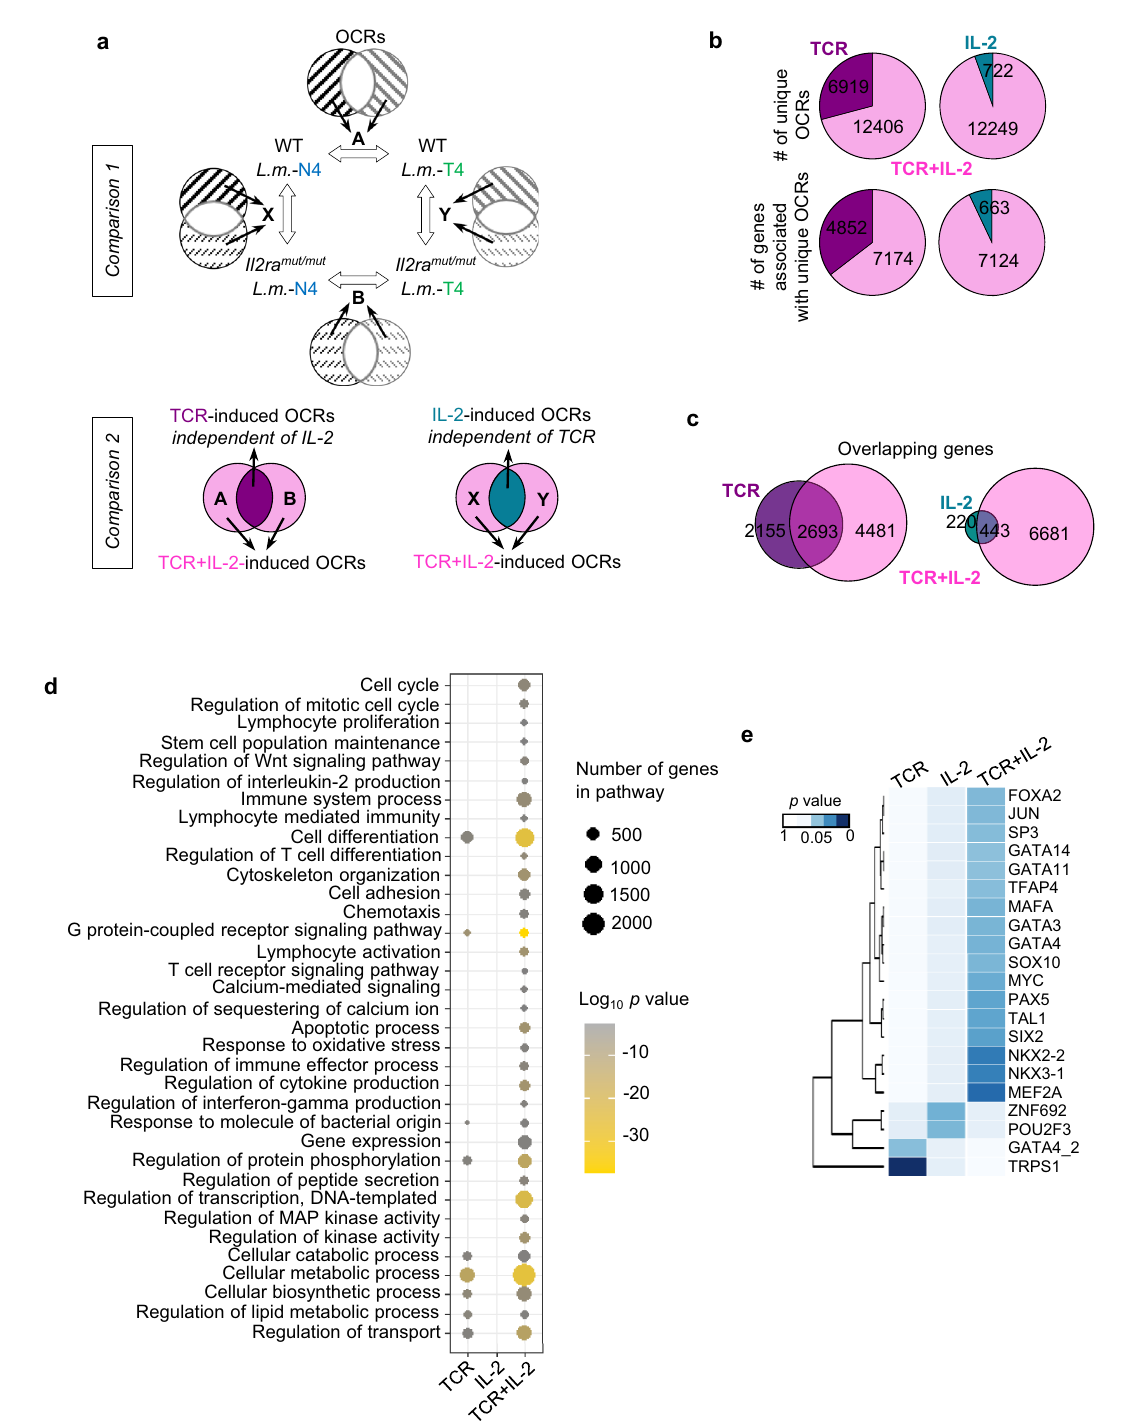
Fig. 6 Extensive chromatin remodeling in memory CD8 + T cells is observed upon combined changes in both TCR and IL-2 signaling strength. a Schematic of the comparative analyses conducted between the open chromatin regions (OCRs) in OT-I memory cells (WT, Il2ra mut/mut ) primed following Lm -N4 versus Lm- T4 infection. b Pie charts show the number of unique OCRs and related genes with unique peaks controlled by changes in TCR, IL-2 or TCR + IL-2 signaling from comparisons depicted in (A). c Venn diagrams show the number of unique or overlapping genes associated with peaks induced by modulating TCR, IL-2 or TCR + IL-2 signals. d Network analysis of biological-process GO term enrichment of the genes with unique peaks induced by changes in TCR, IL-2 or TCR + IL-2 signals. Over-represented GO terms were analyzed by Panther and visualized in a scatterplot. Node color is proportional to the FDR-adjusted p -value of the enrichment. Node size is proportional to the number of genes enriched in each GO term. Enrich in ClusterPro fi ler was used (over-representation analysis with FDR correction Benjamini and Hochberg. e Heat map shows the transcription factors enriched in unique OCRs induced by modulating TCR, IL-2 or TCR + IL-2 signals. ATAC-seq ( n = 3 – 4 mice) results were summarized from 2 independent replicates of experiments. A linear model was